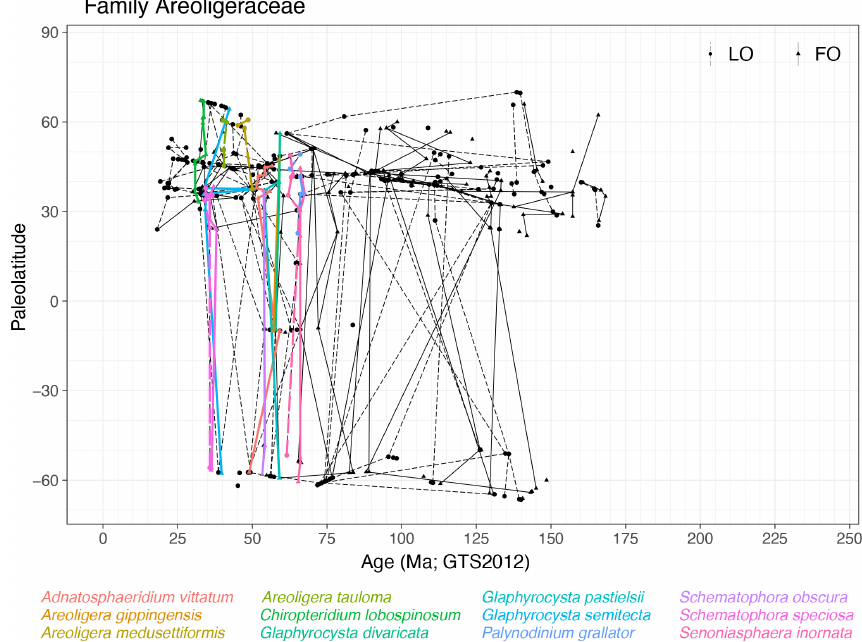
Figure 5. Ages and paleolatitudes of first (solid line and triangles) and last (dashed line and circles) occurrences of dinocyst species of the family Areoligeraceae. Solid and dashed lines connect first and last occurrences, respectively, for each species, between sites. Colored lines represent quasi-synchronous species events.